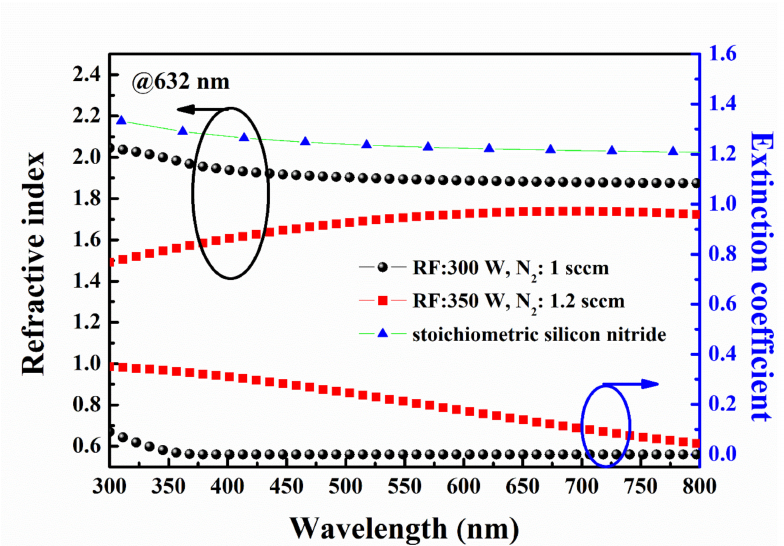
Figure 1. Ellipsometer spectra of Si x N y ultra-thin films. For a nitridation time of 60 min, the refractive index ( n ) of Si x N y film is close to 1.88 at 632 nm with RF: 300 W and N 2 : ~1 sccm.